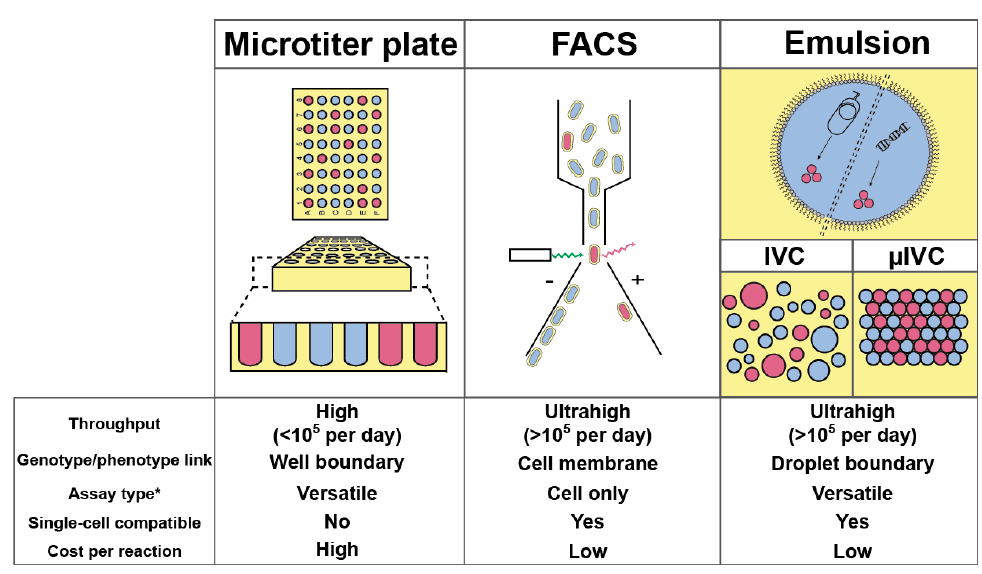
Figure 1. Principal (ultra)high-throughput screening strategies for enzyme improvement/discovery. The different methods (Microtiter plate, fluorescence-activated cell sorting (FACS) and emulsion) are schematized with the boundary (well, cell membrane, or oil) confining the phenotype with the genotype shaded in yellow. High-throughput (up to 10 5 analyses par day) is distinguished from ultrahigh-throughput (more than 10 5 analyses per day) regimes. Note that the emulsion-based approach is represented its two format: (i) in vitro compartmentalization (IVC) manipulating polydisperse emulsions and (ii) microfluidic-assisted IVC (µIVC) manipulating highly monodisperse emulsions. Compartments containing the target phenotype (red) are discriminated from those that do not possess it (blue). *Assay type can be cell-based, cell lysate-based, cell-free, or all of them (versatile).